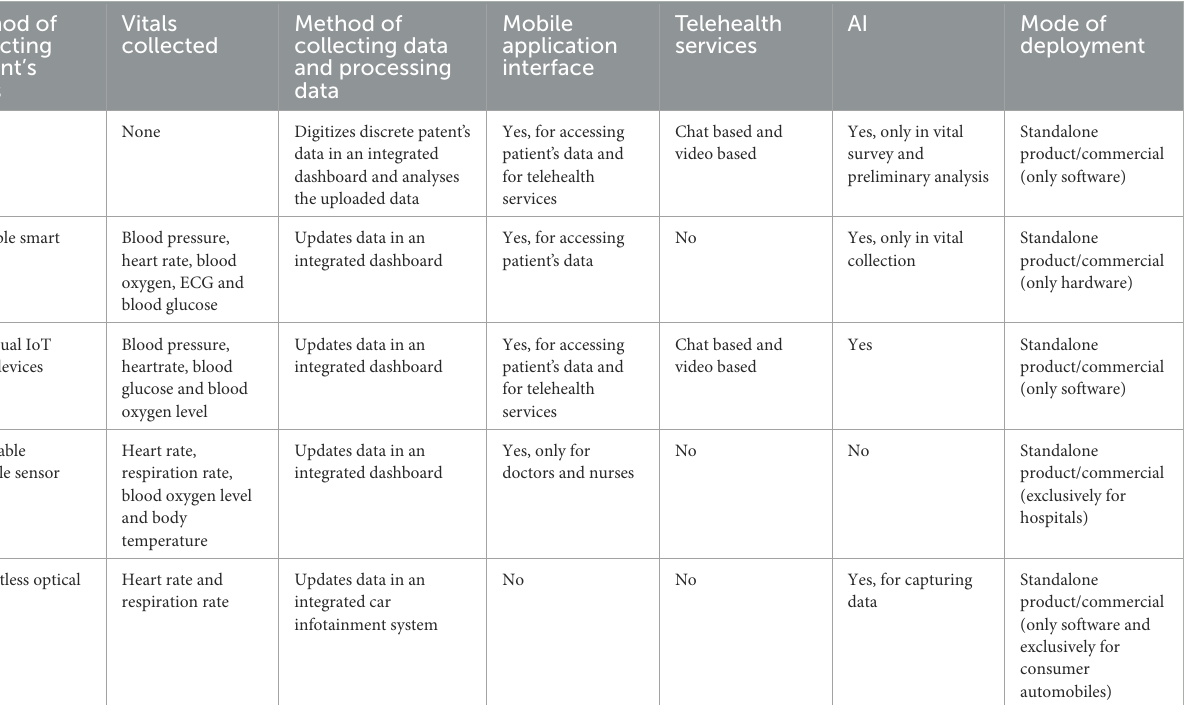
TABLE 1 Summary of the reviewed commercial smart health monitoring systems. S.